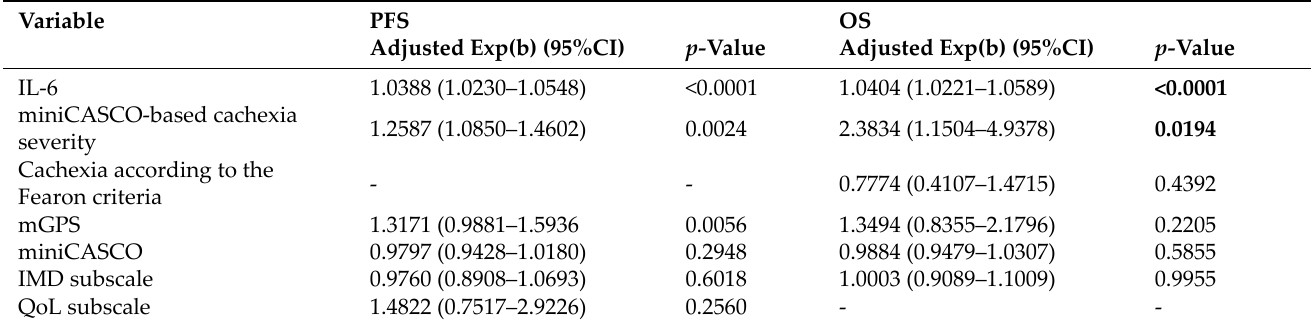
Table 4. Multivariate COX regression analysis of the variables associated with PFS and